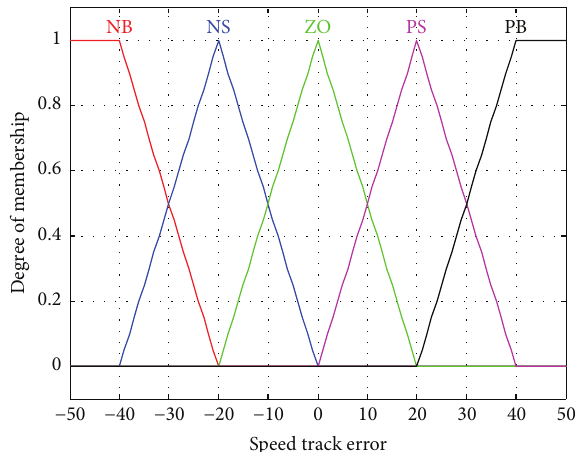
Figure 3: The membership functions for the speed tracking